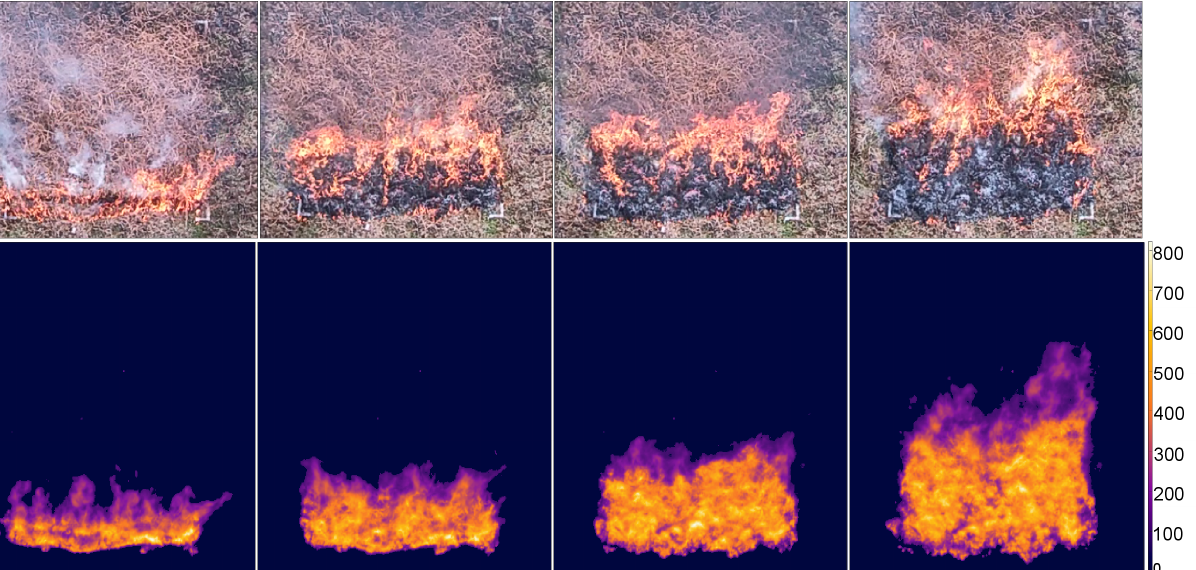
Figure 2. Visual ( top ) and infrared ( bottom ) camera frames at four time steps spaced approximately 10 s apart. The frames of the individual cameras are not perfectly synchronized.